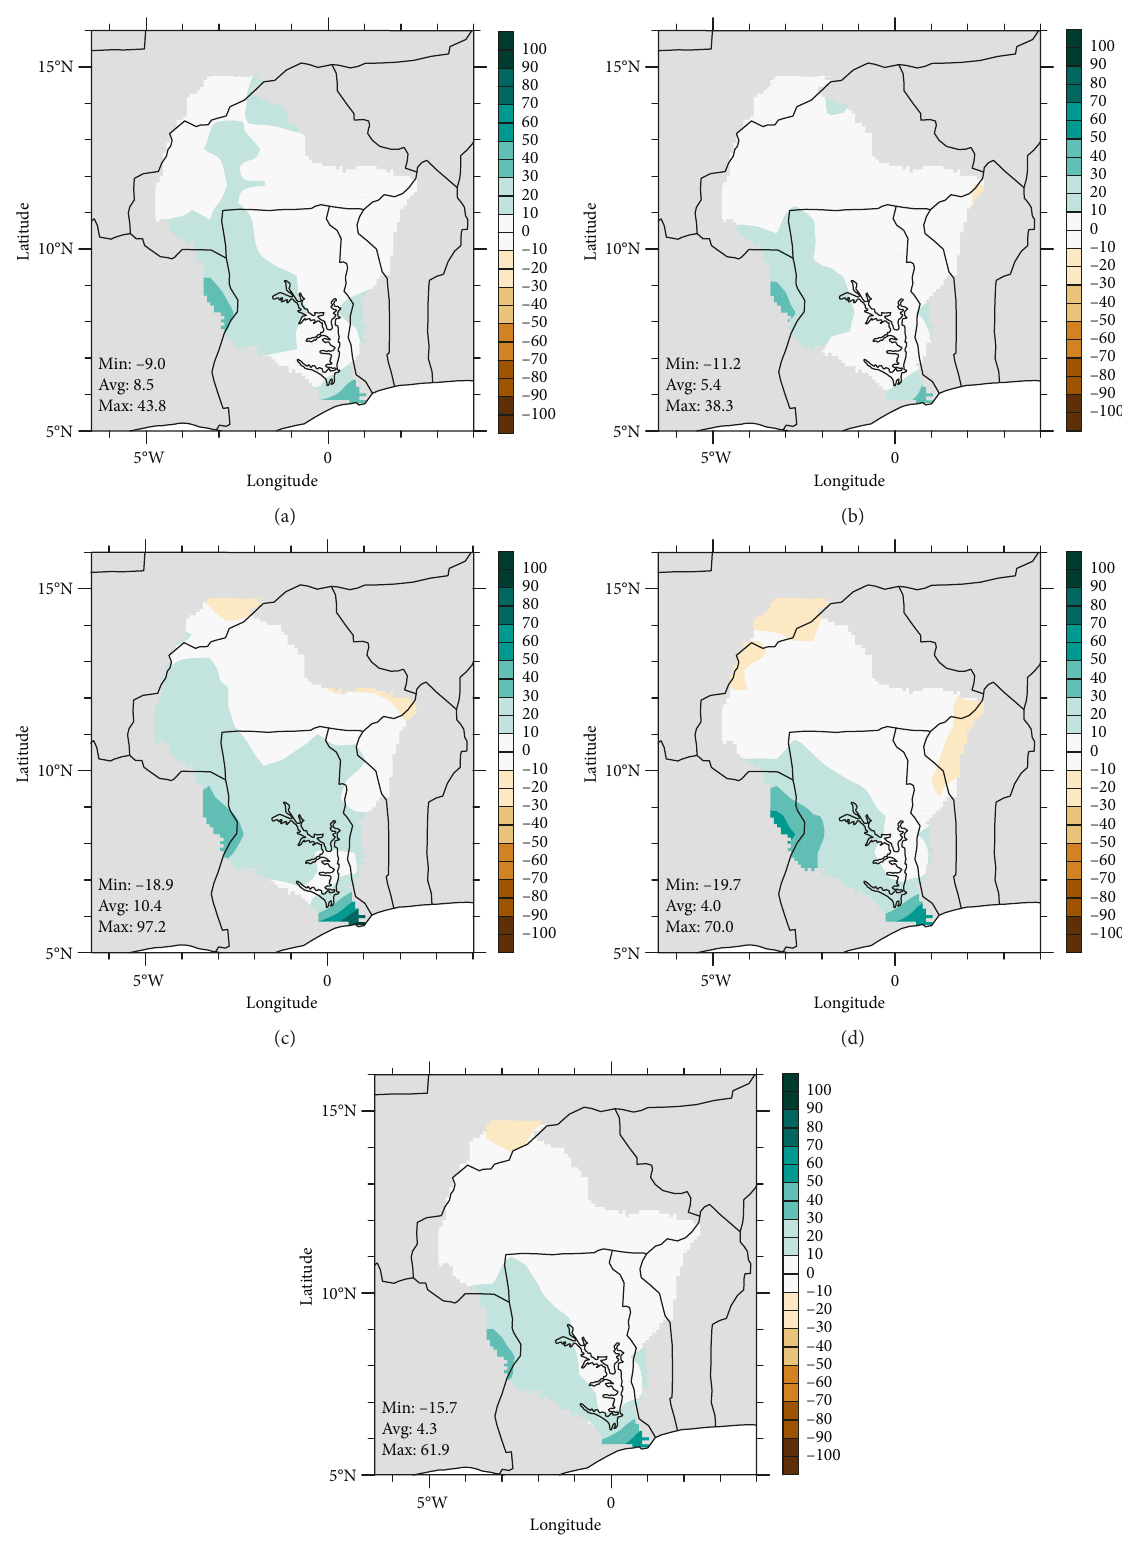
Figure 7: The climatological (1950–2004) mean bias in the seasonal totals of the models: CCSM4 (a), CESM1-BGC (b), MPI-ESM-MR (c), NorESM1-M (d), and ensemble mean (e), with least annual climatological mean biases for the rainy season over the Volta